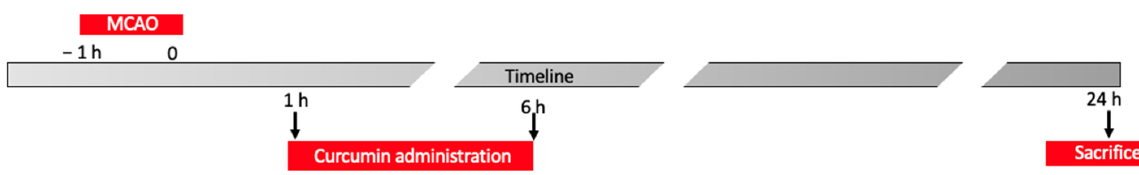
Figure 1. Experimental protocol 1.